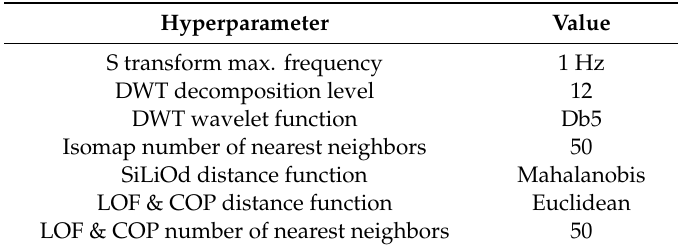
Table 8. Hyperparameters used for the disturbance extraction